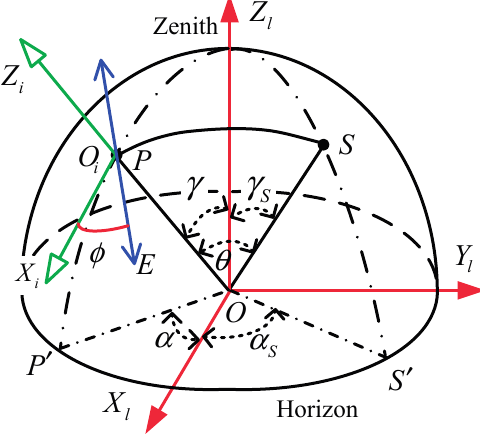
Figure 4. Description of the single scattering Rayleigh